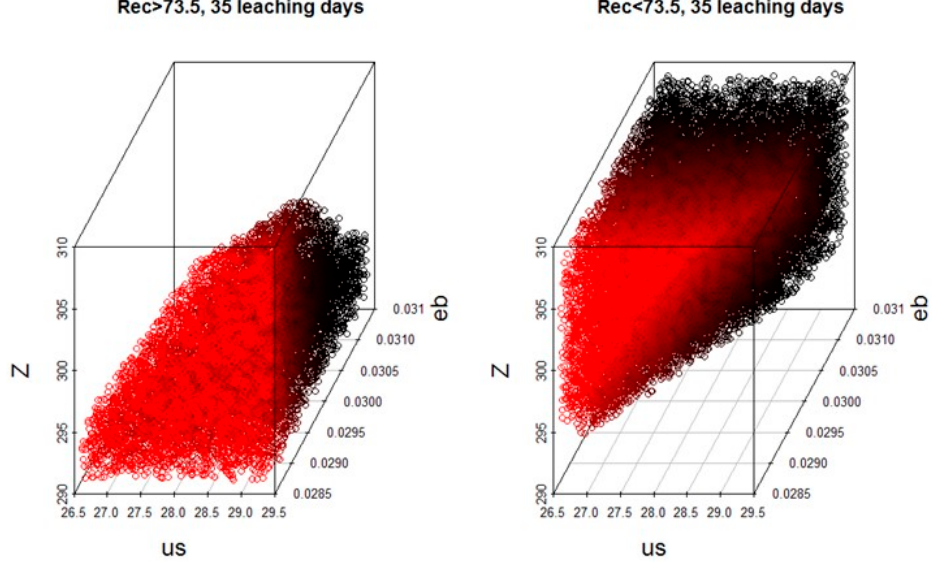
Figure 15. Regionalization of the influential input variables Z , u s and (cid:101) b , B ( left ) and B ( right ).